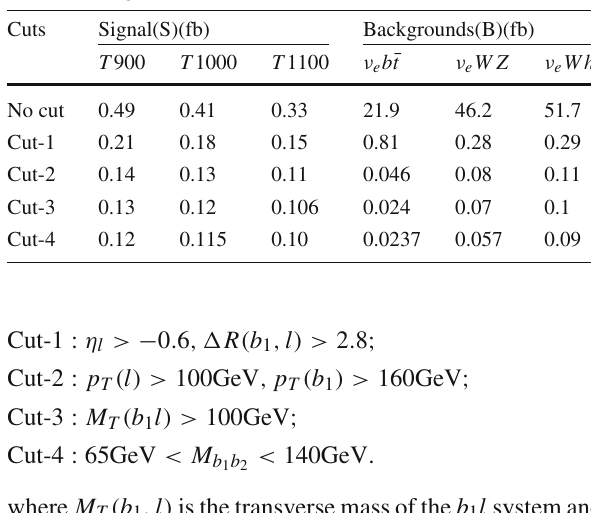
parameters m T and g ∗ within the region m T ∈ [ 800 , 1800 ] GeV and g ∗ ∈ [ 0 . 0 , 0 . 5 ] , and take the SM parameters as follows [39] sin 2 θ W = 0 . 231 , α e = 1 / 128 , M Z = 91 . 1876GeV , m t = 173 . 5GeV , m h = 125GeV .